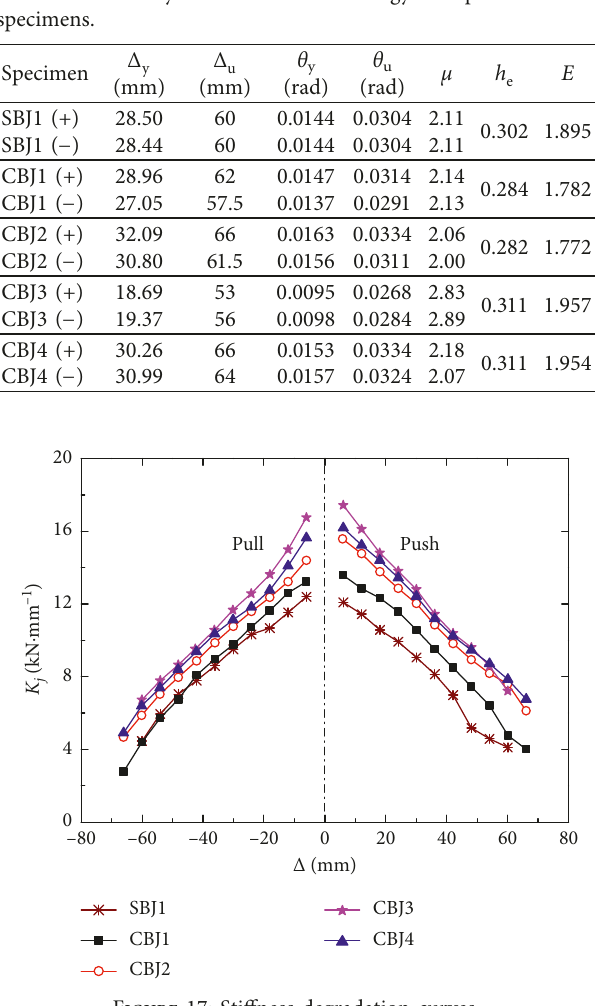
Figure 17: Stiffness degradation